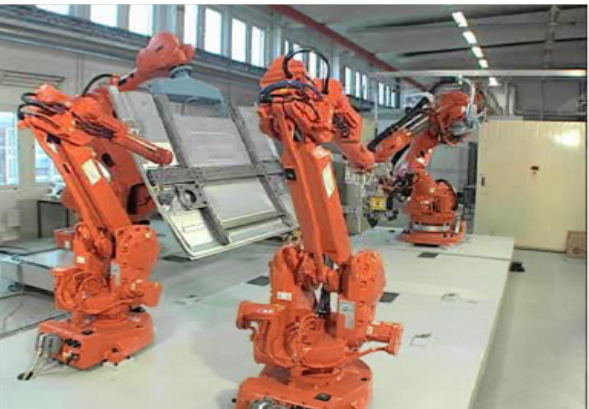
Figure 8: Four collaborating robots controlled according to the ABB MultiMove concept. One robot handles the work object while the 3 other robots simultaneously (and coordinated) per- form different processes on the work